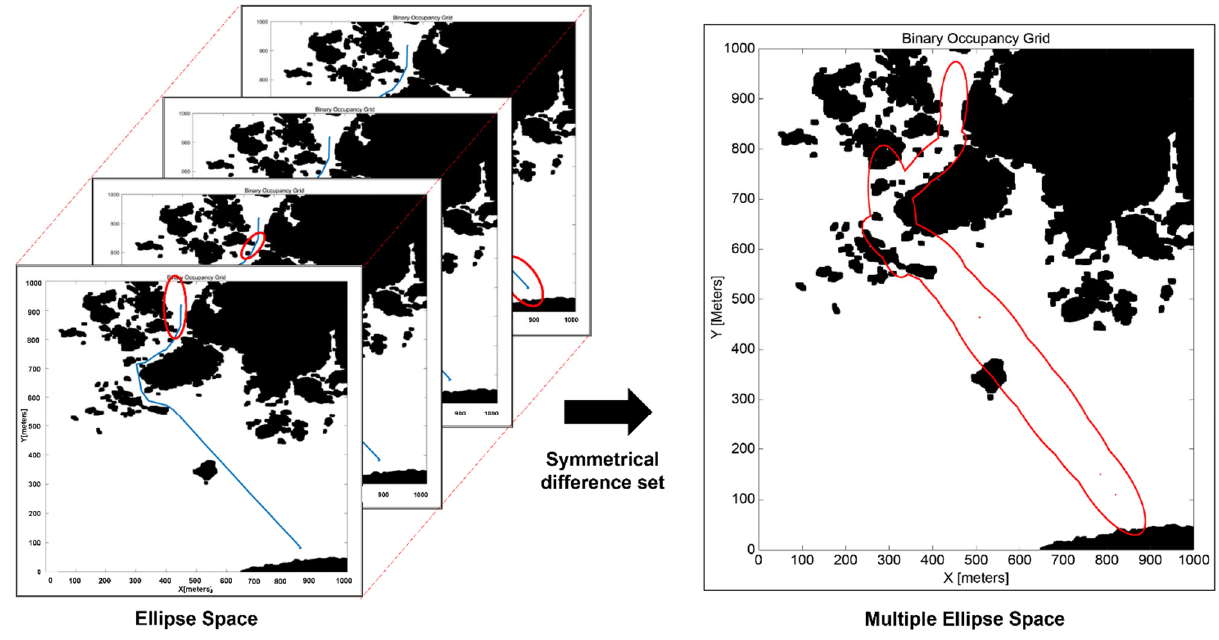
Figure 19. The process of generating a multi ‐ ellipse space.